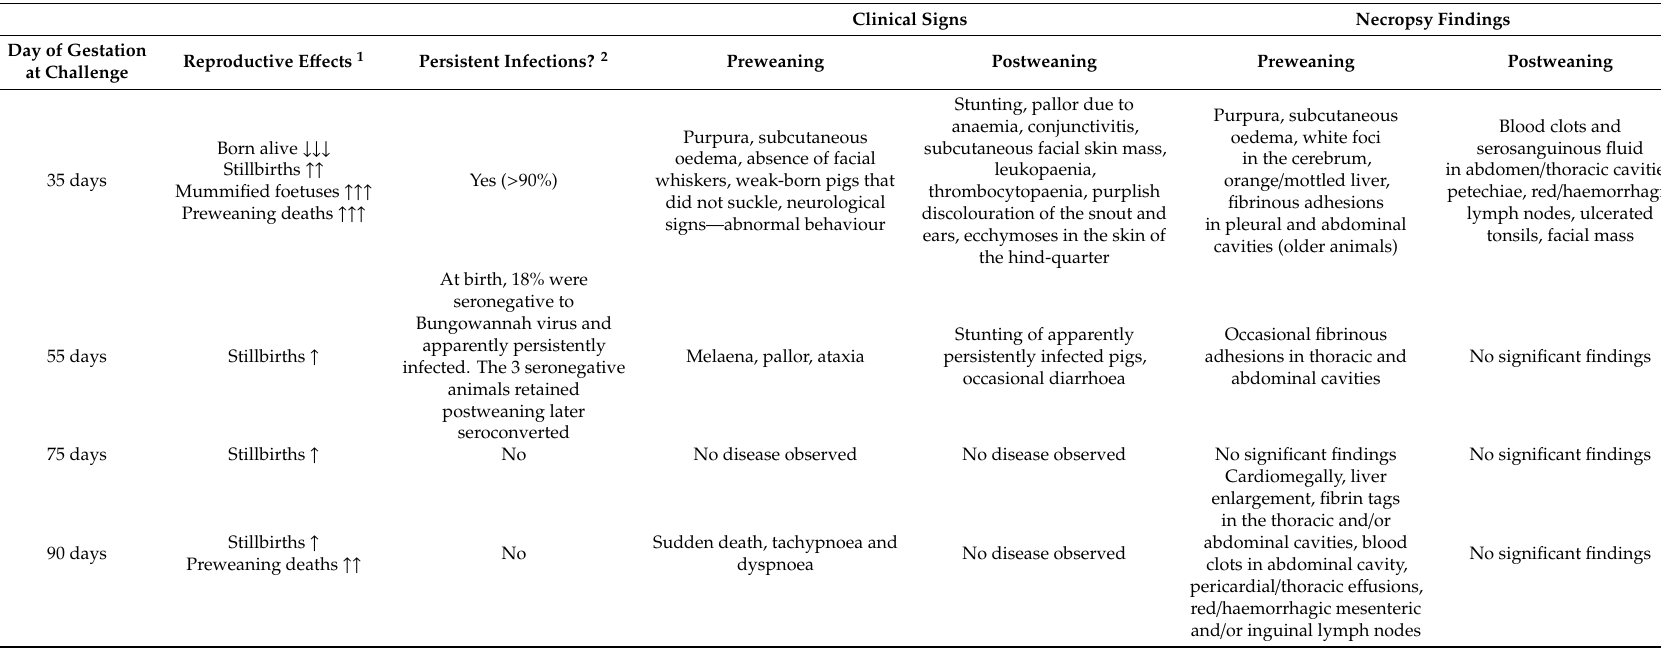
Table 2. Summary of the reproductive e ff ects, and most common clinical signs and necropsy findings following in utero infection with Bungowannah